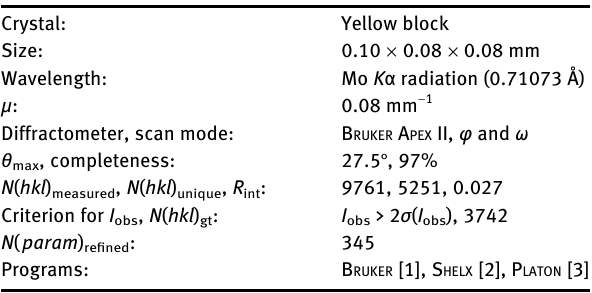
Table  : Data collection and